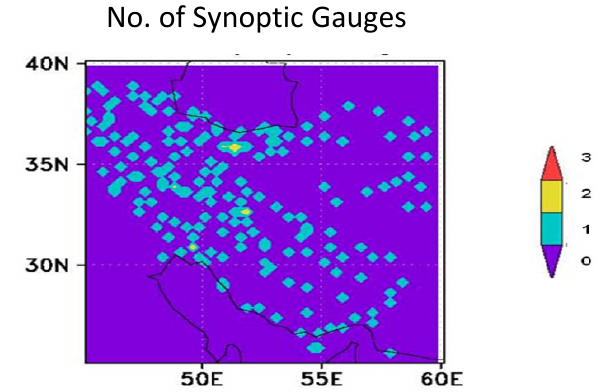
Fig. 3. Time series of the number of synoptic gauges used in this study.